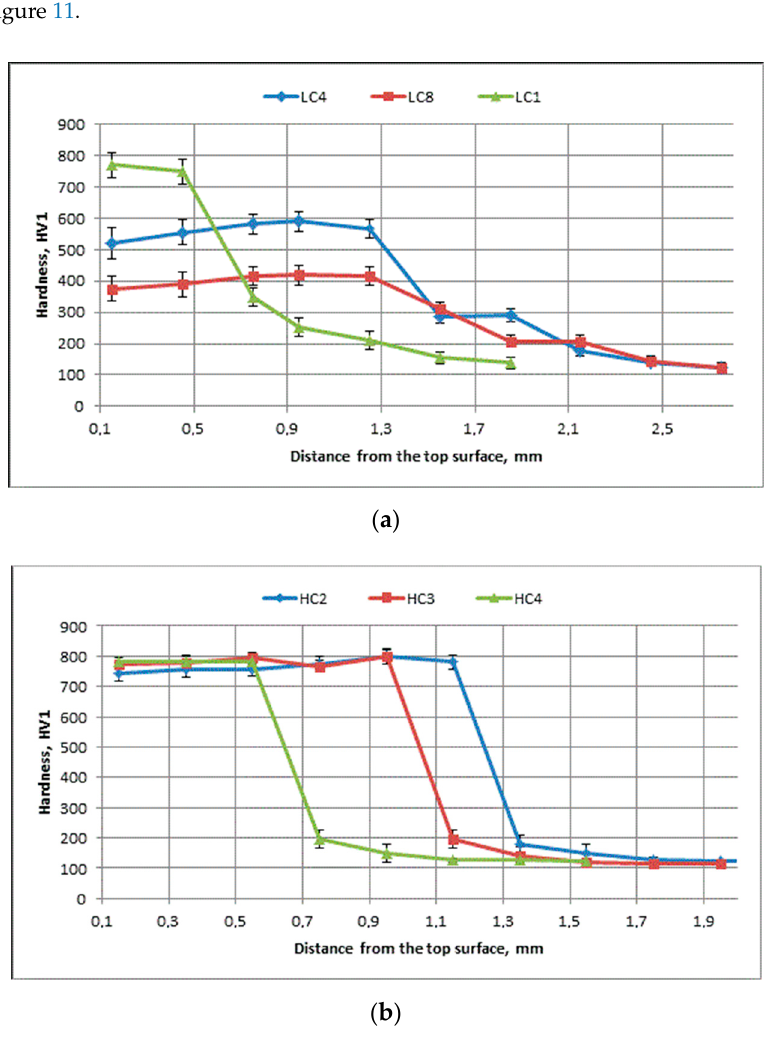
Figure 11. Hardness distribution on cross-sections of the representative stringer beads produced by the laser deposition of experimental Fe-based metallic powder (Table 3, Figure 10): ( a ) at free cooling conditions (conventional laser cladding); and ( b ) at forced cooling by liquid nitrogen bath under cryogenic conditions (hybrid laser deposition process).